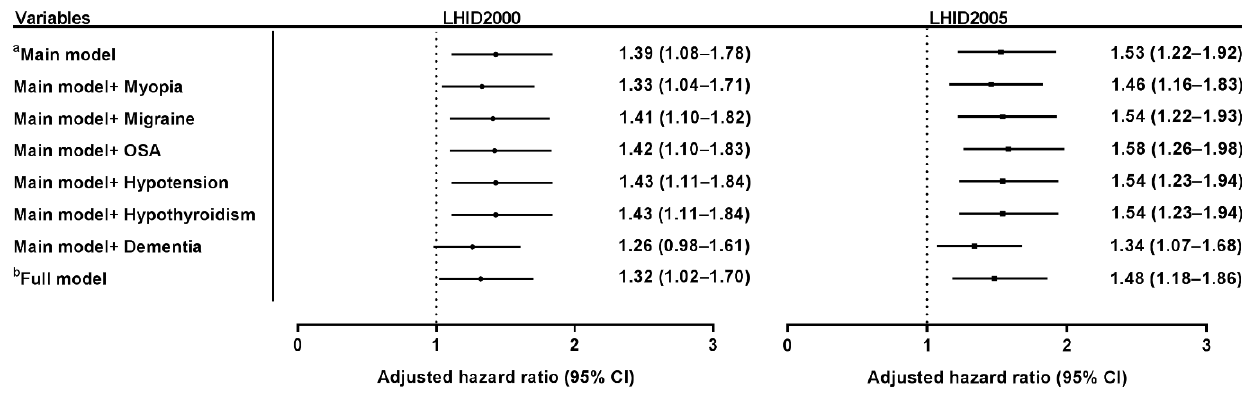
Figure 3. Sensitivity analysis of the risk of open-angle glaucoma in obesity. Sensitivity analysis in both the LHID2000 and LHID2005 showed that the adjusted hazard ratio of OAG remained stable after being adjusted according to the full model and main model with each potential covariate (myopia, migraine, OSA, hypotension, and hypothyroidism). The adjusted hazard ratio of OAG was 1.32 to 1.43 in the LHID2000, and 1.49 to 1.58 in the LHID2005. a Main model adjusted for age, gender, income, urbanization, diabetes mellitus, hypertension, hyperlipidemia, ischemic heart disease, and chronic kidney disease b Full model adjusted for the main model, myopia, hypothyroidism, migraine, OSA, and hypotension. OAG = open-angle glaucoma; OSA = obstructive sleep